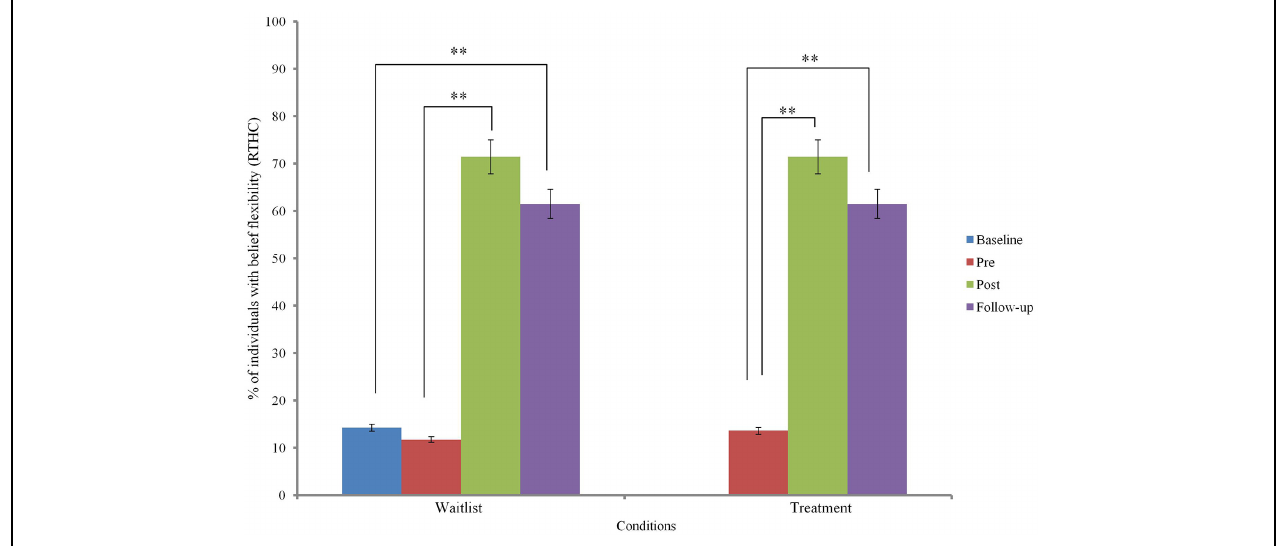
FIGURE 4 | Reaction to hypothetical contradiction (RTHC) across groups. ∗∗ indicates p <